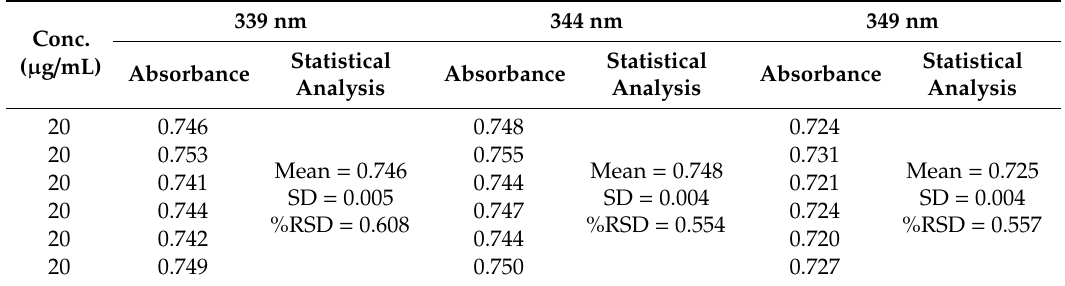
Table 10. Statistical validation for robustness studies using UV-vis spectrophotometer. Conc.